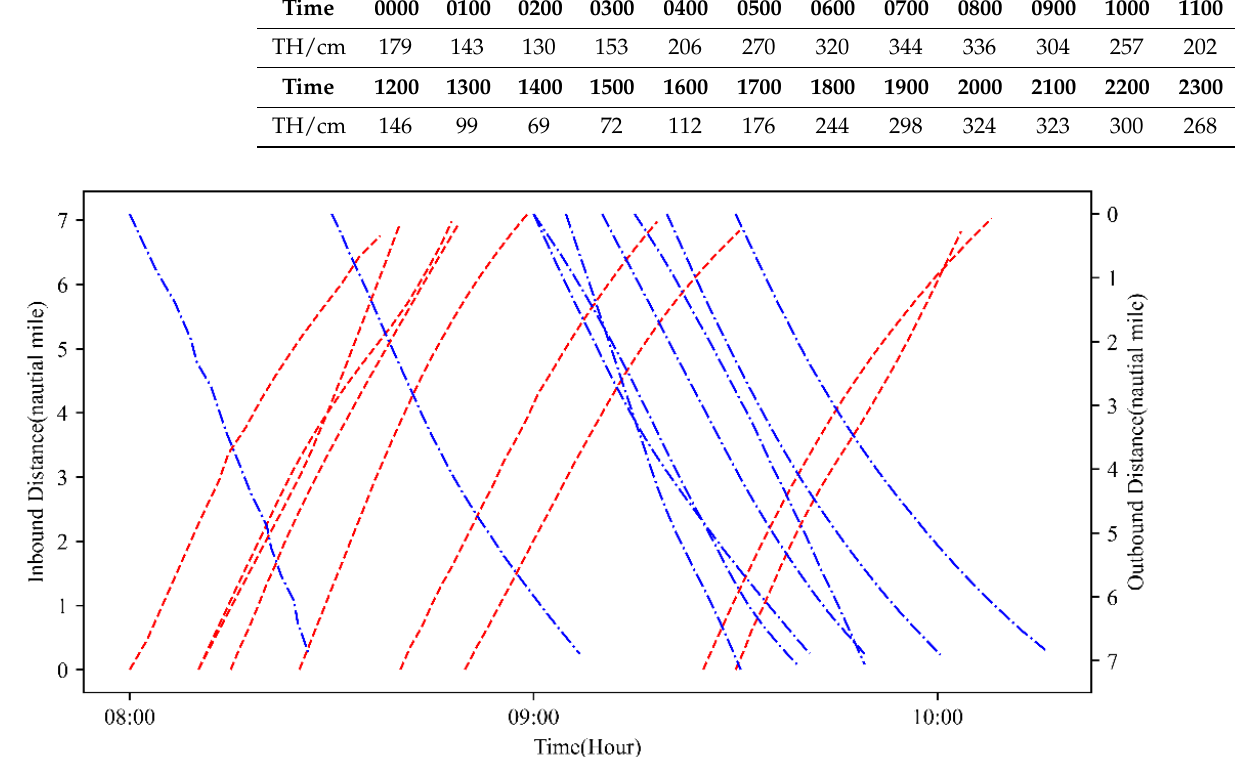
Figure 8. Temporal − spatial trajectories of 18 vessels.